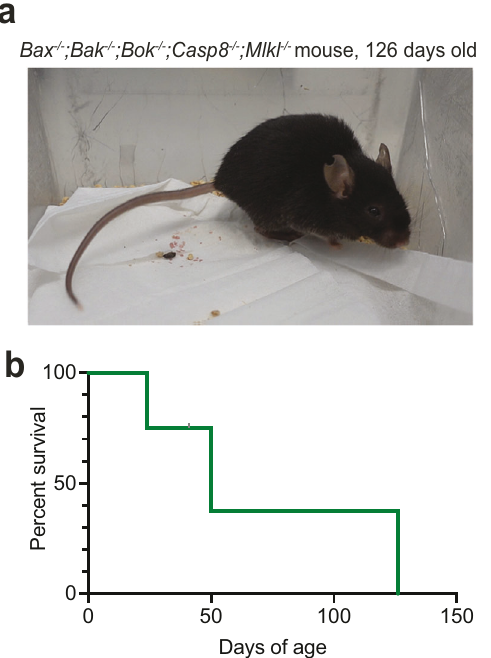
Fig. 1 A small number of Bax − / − ;Bak − / − ;Bok − / − ;Casp8 − / − ;Mlkl − / − quintuple knockout (Q5KO) mice can reach adulthood. a Image of the longest surviving Bax − / − ;Bak − / − ;Bok − / − ;Casp8 − / − ;Mlkl − / − quintu- ple knockout mouse at 126 days of age. b Survival curve of Bax − / − ; Bak − / − ;Bok − / − ;Casp8 − / − ;Mlkl − / − quintuple knockout mice that sur- vived the early postnatal period. Bax − / − ;Bak − / − ;Bok − / − ;Casp8 − / − ; Mlkl − / − quintuple knockout mice survived to 50, 24, and 126